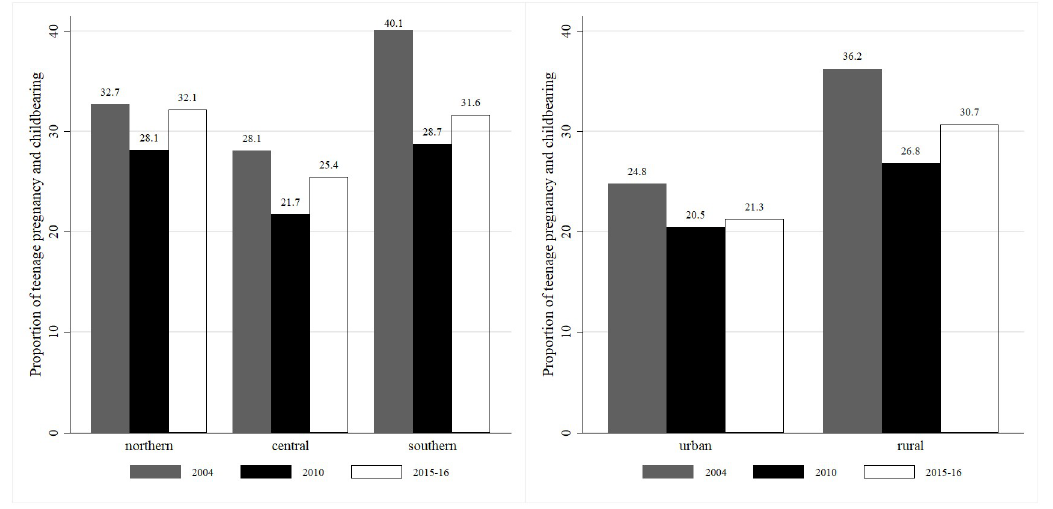
Fig 2. Teenage pregnancy and childbearing trend by region and residence 2004-2015-16. Constructed by authors from MDHS 2004, 2010, 2015–16.